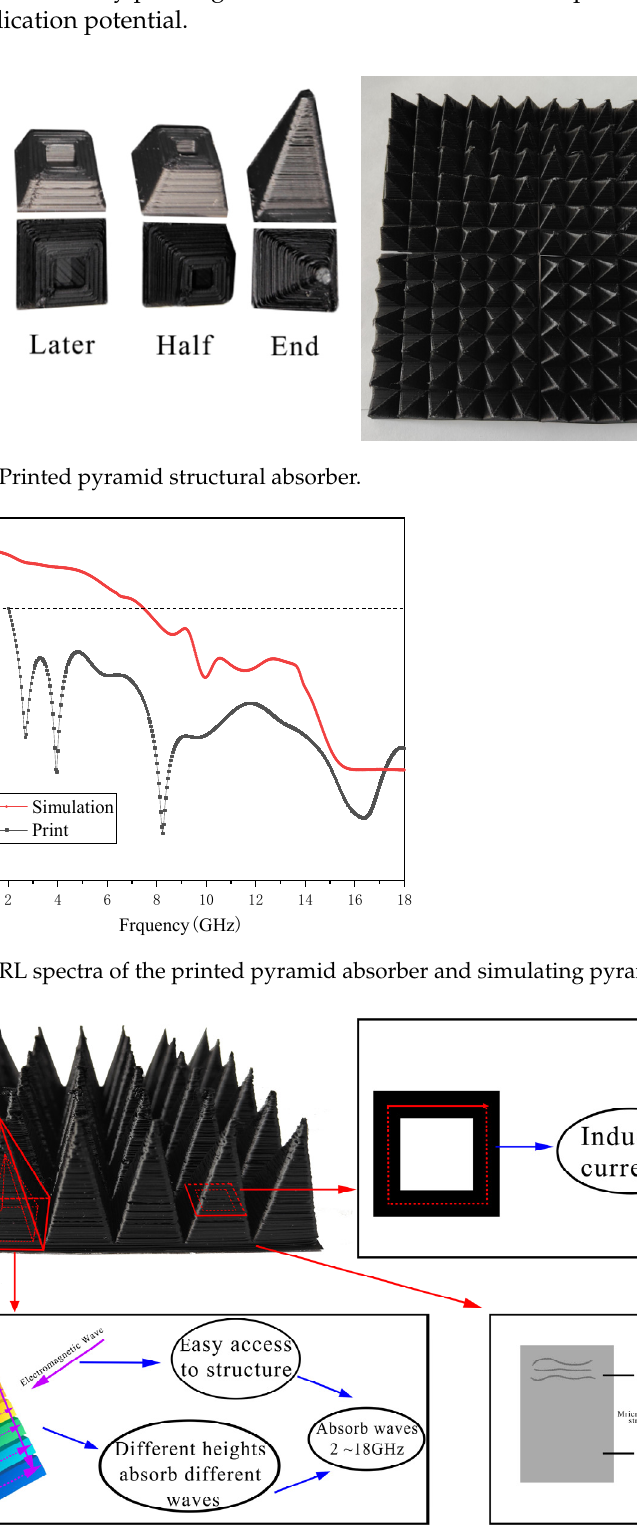
Figure 17. Printed pyramid structural absorber.